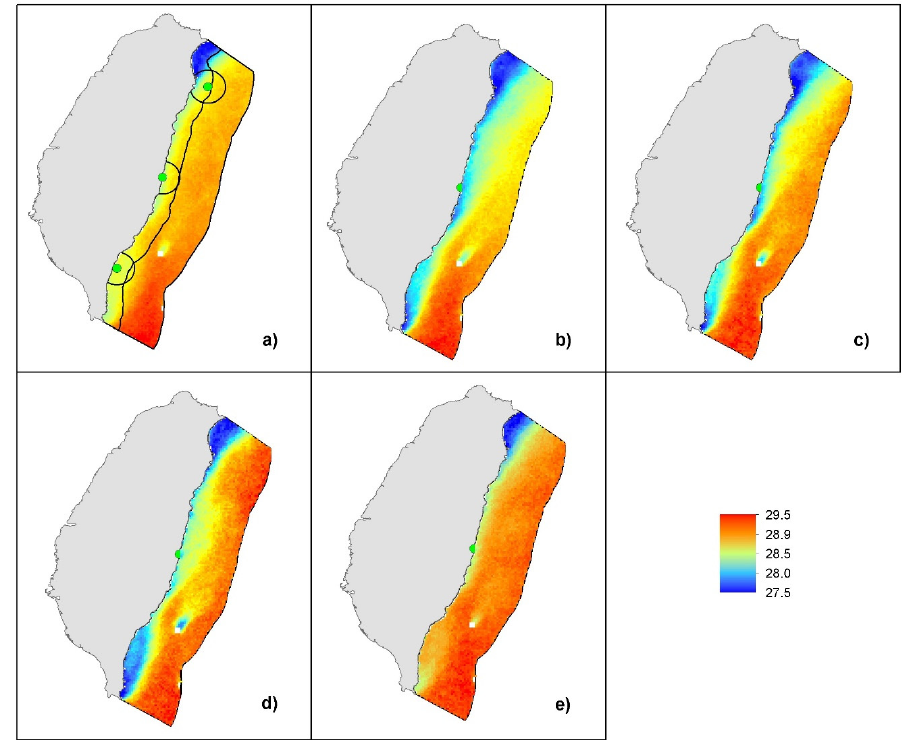
Figure 13. The monthly-averaged SST maps were generated by combining the daily SST maps of the corresponding months; ( a ) May, ( b ) June, ( c ) July, ( d ) August, ( e ) September.